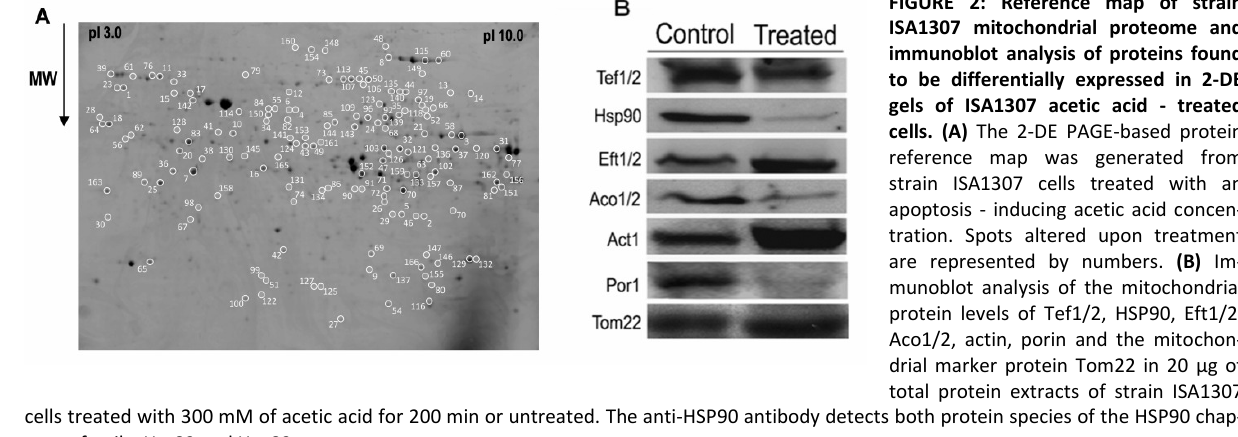
FIGURE 2: Reference map of strain ISA1307 mitochondrial proteome and immunoblot analysis of proteins found